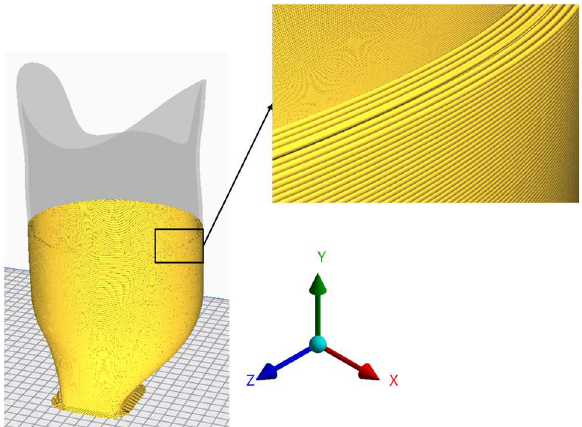
Figure 12. Printing setup with coordinate system—the printing direction follows the y-axis.